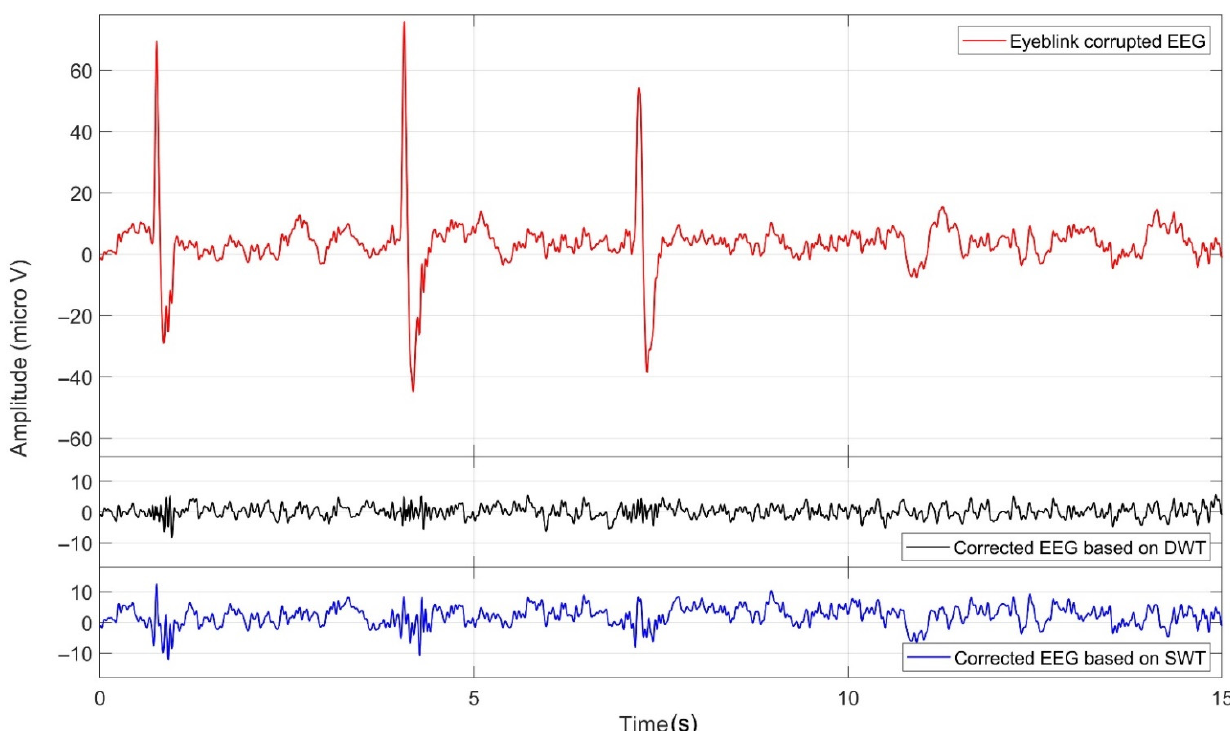
Figure 2. Eyeblink corrupted EEG signal in red, corrected EEG signal based on DWT in black and SWT in